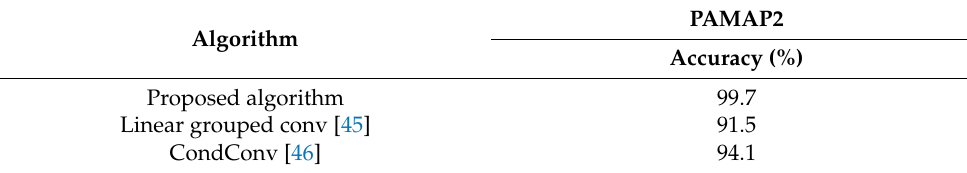
Table 6. Comparison of previous algorithms and proposed model in